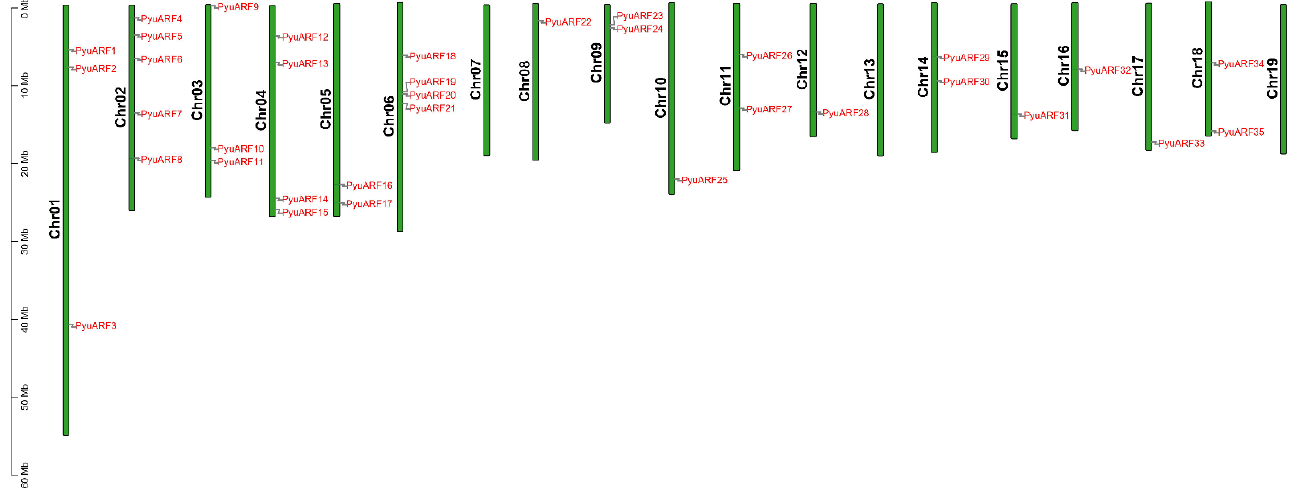
Figure 4. Schematic representation of the chromosomal distribution of the PyuARFs . The vertical bars indicate the chromosomes of P. yunnanensis . The chromosome number is located to the left of each chromosome. The scale on the left represents the chromosome length. The PyuARF genes are marked in red.